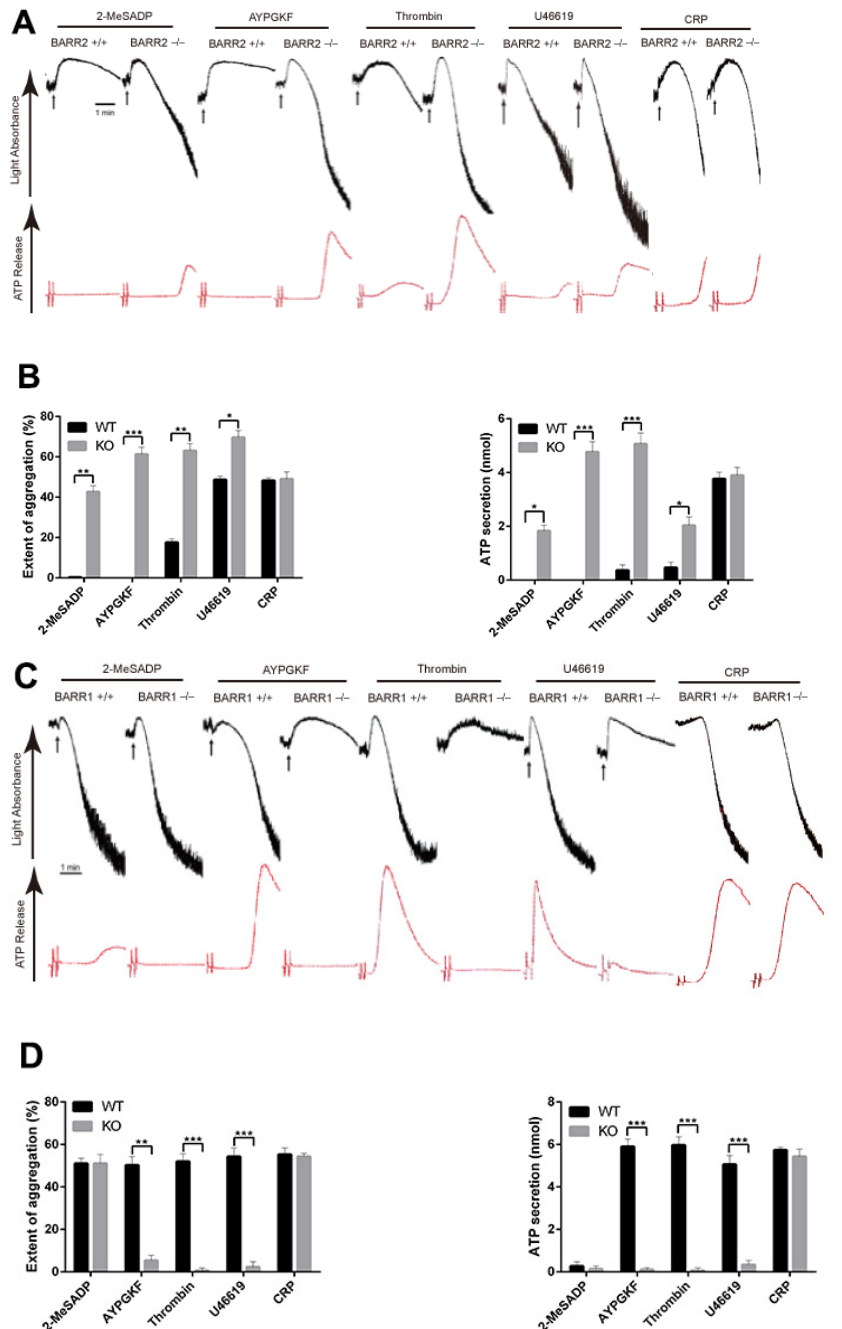
Figure 2. Comparison of agonist-induced platelet aggregation and secretion. ( A ) Washed platelets from arrestin3 − / − (BARR2 − / − ) mice and WT (BARR2 +/+) littermates were stimulated with GPCR agonists 30 nM 2-MeSADP, 60 µ M AYPGKF, 0.1 U/mL thrombin, and 50 nM U46619 and GPVI agonist 2.5 µ g/mL CRP. ( B ) Quantification of extent of aggregation and dense granule secretion from panel A. Data are presented as mean ± SE *, p < 0.05; **, p < 0.01; ***, p < 0.005. ( C ) Washed platelets from arrestin2 − / − (BARR1 − / − ) mice and WT (BARR1 +/+) littermates were stimulated with GPCR agonists 50 nM 2-MeSADP, 100 µM AYPGKF, 0.15 U/mL thrombin, and 75 nM U46619 and GPVI agonist 2.5 µg/mL CRP. ( D ) Results quantified from panel C and presented as mean ± SE **, p < 0.01; ***, p < 0.005. Platelet aggregation (top) and ATP secretion (bottom) were quantified in a lumi-aggregometer. The data are representative of three independent experiments.